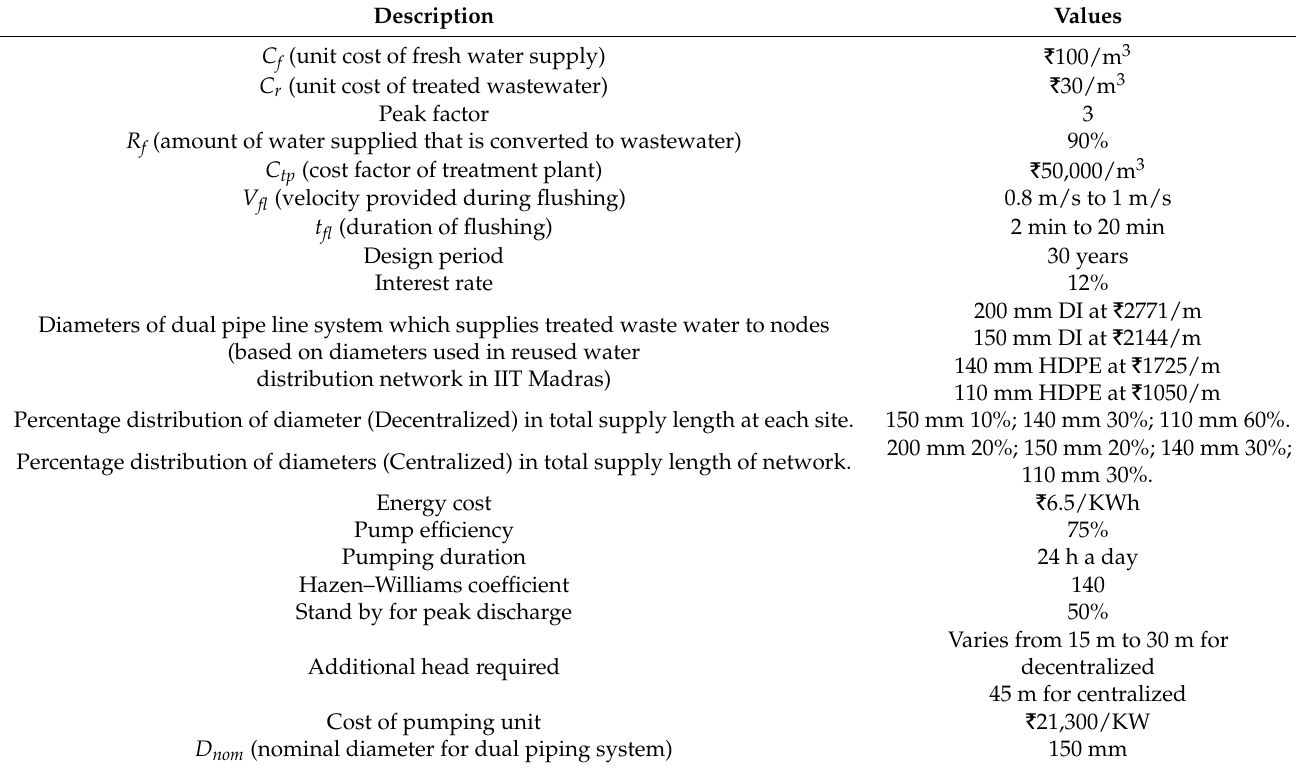
Table 4. Input values for decentralized wastewater treatment and reuse.